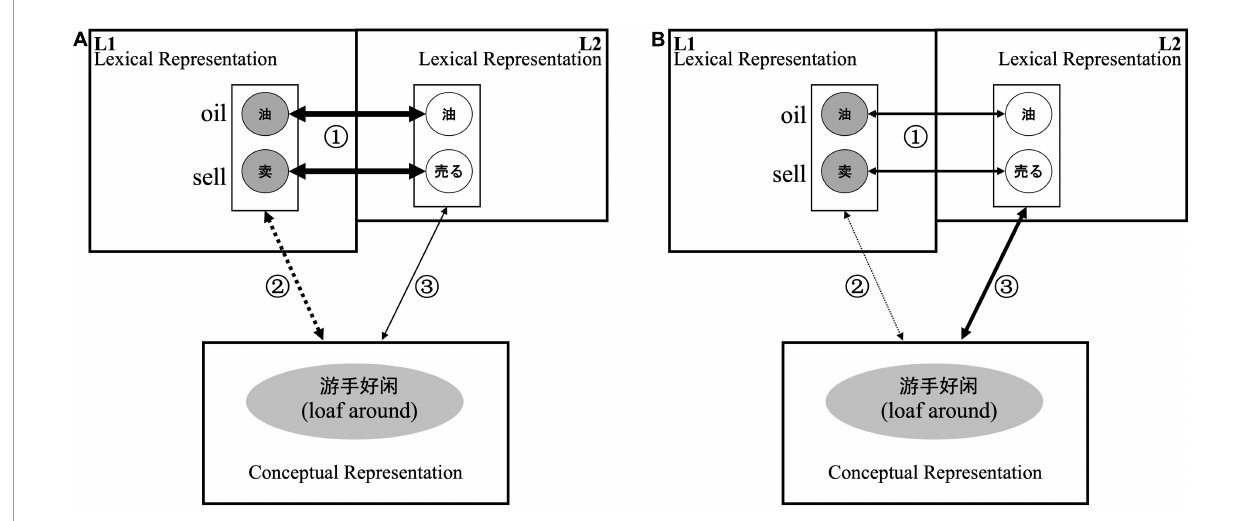
FIGURE7 Processing of an incongruent translational collocation in Chinese JFL learners. The thickness of the arrows indicates the strength of the links between representations and the dotted arrows indicate that direct semantic access is impossible. (A) Represents the processing of incongruent translational collocation upon visual presentation. (B) Represents the processing of incongruent translational collocation upon auditory